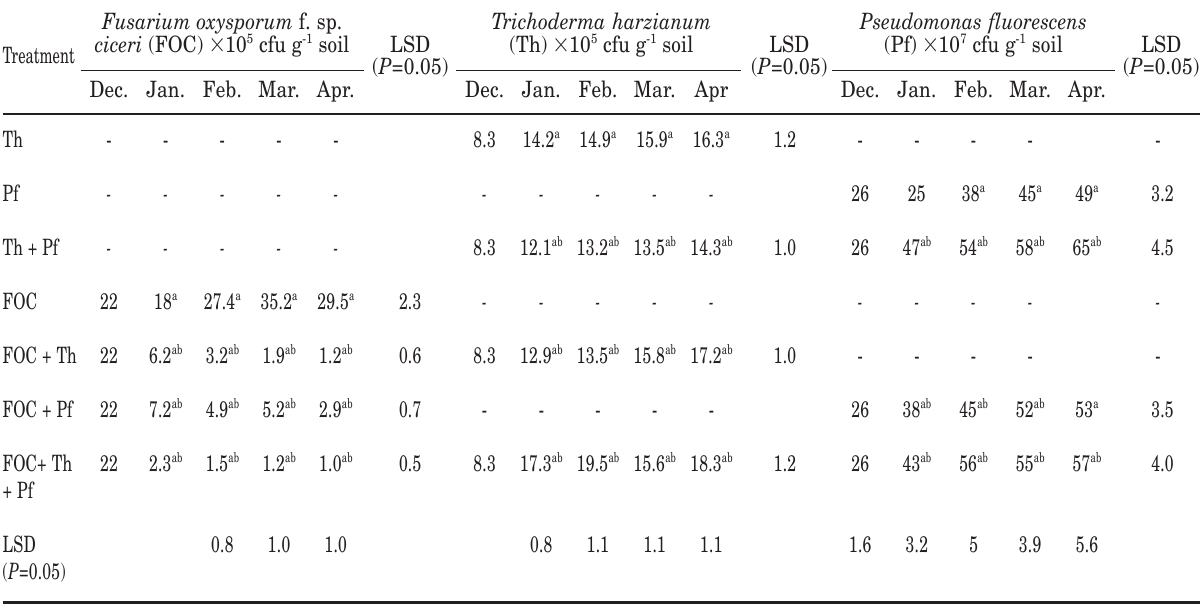
Table 2. Effect of seed treatment of biofungicides on the rhizosphere population of Fusarium oxysporum f. sp. ciceri , Trichoderma harzianum and Pseudomonas